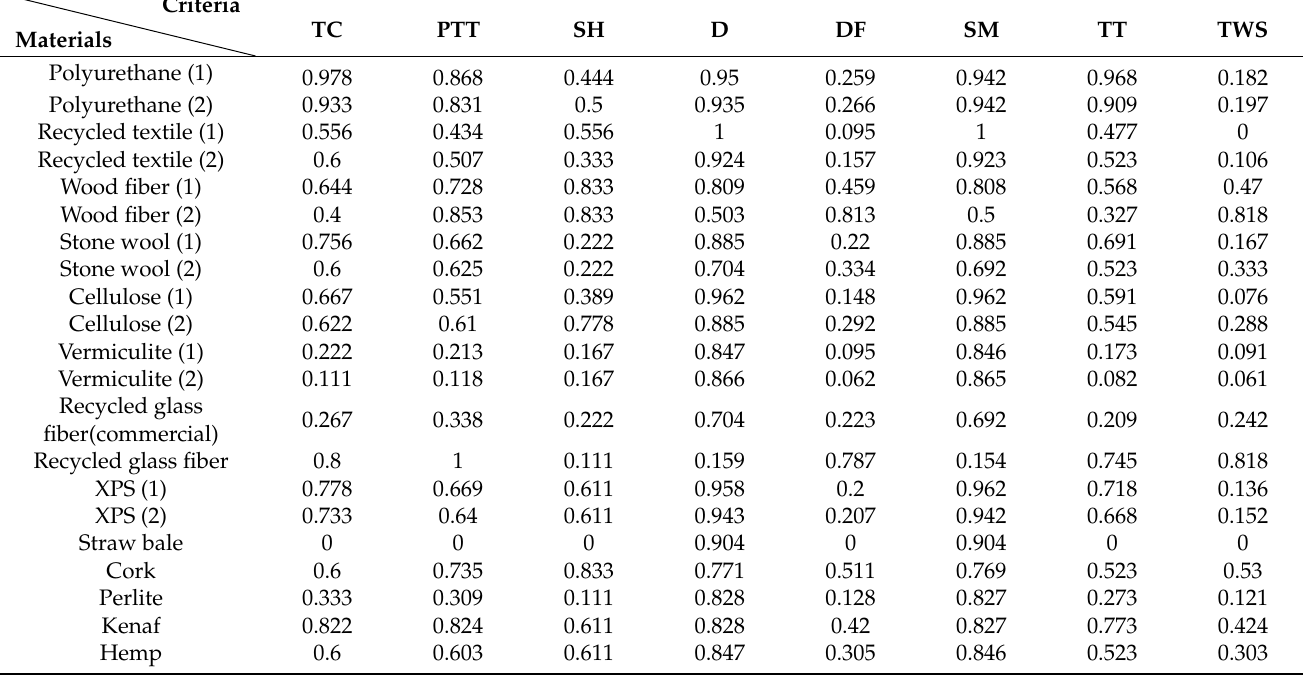
Table 9. The results of Normalization Procedure